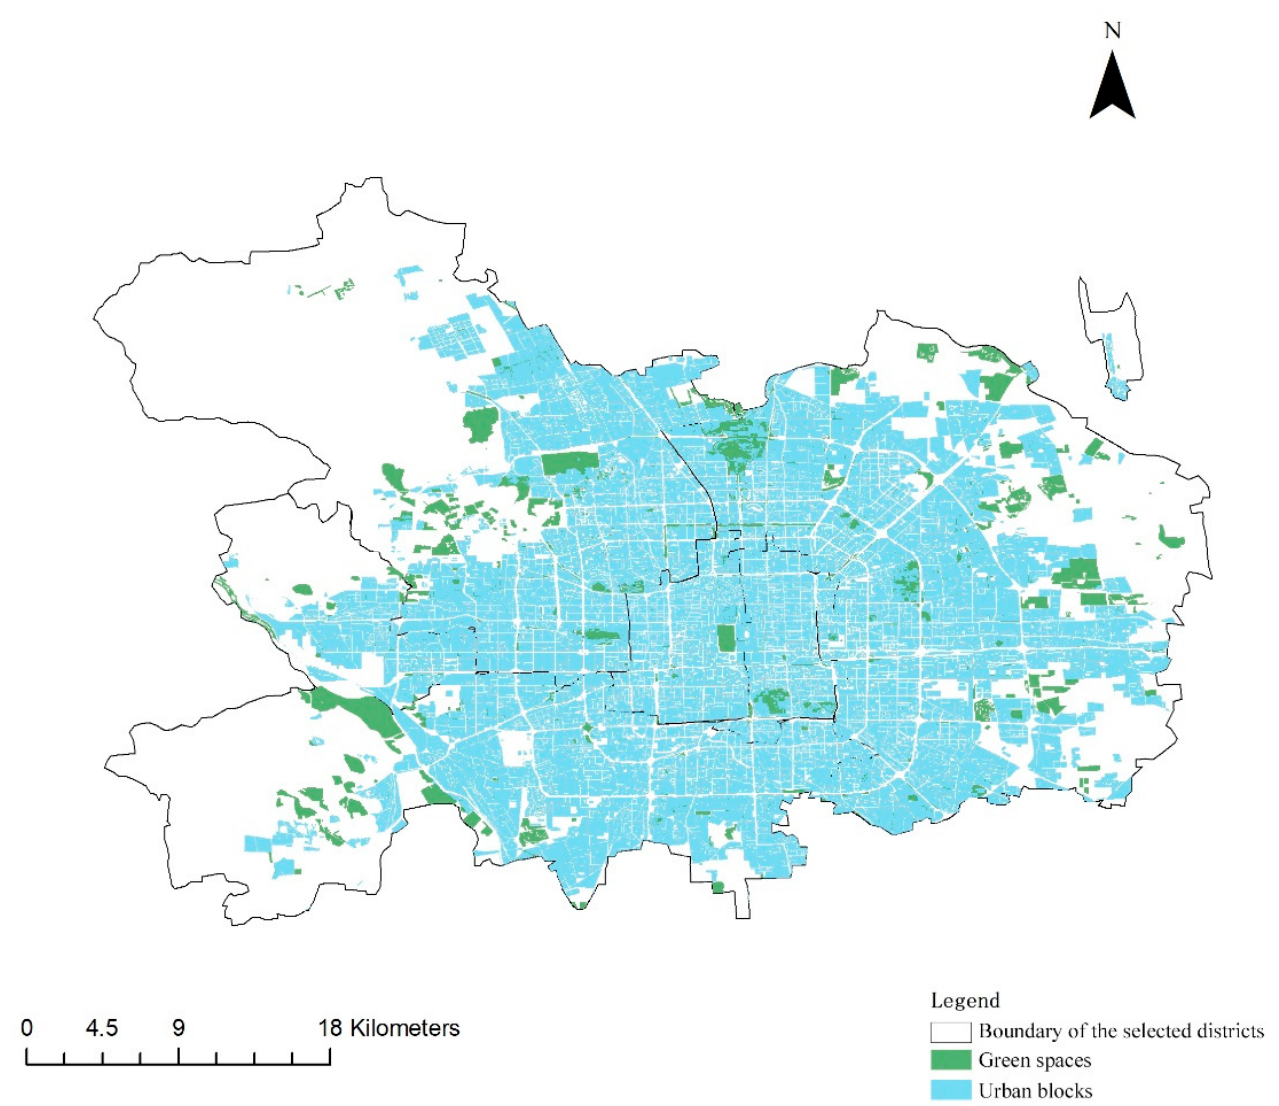
Figure 1. Displays the distribution of boundary of selected districts, green spaces, and urban blocks in Beijing.